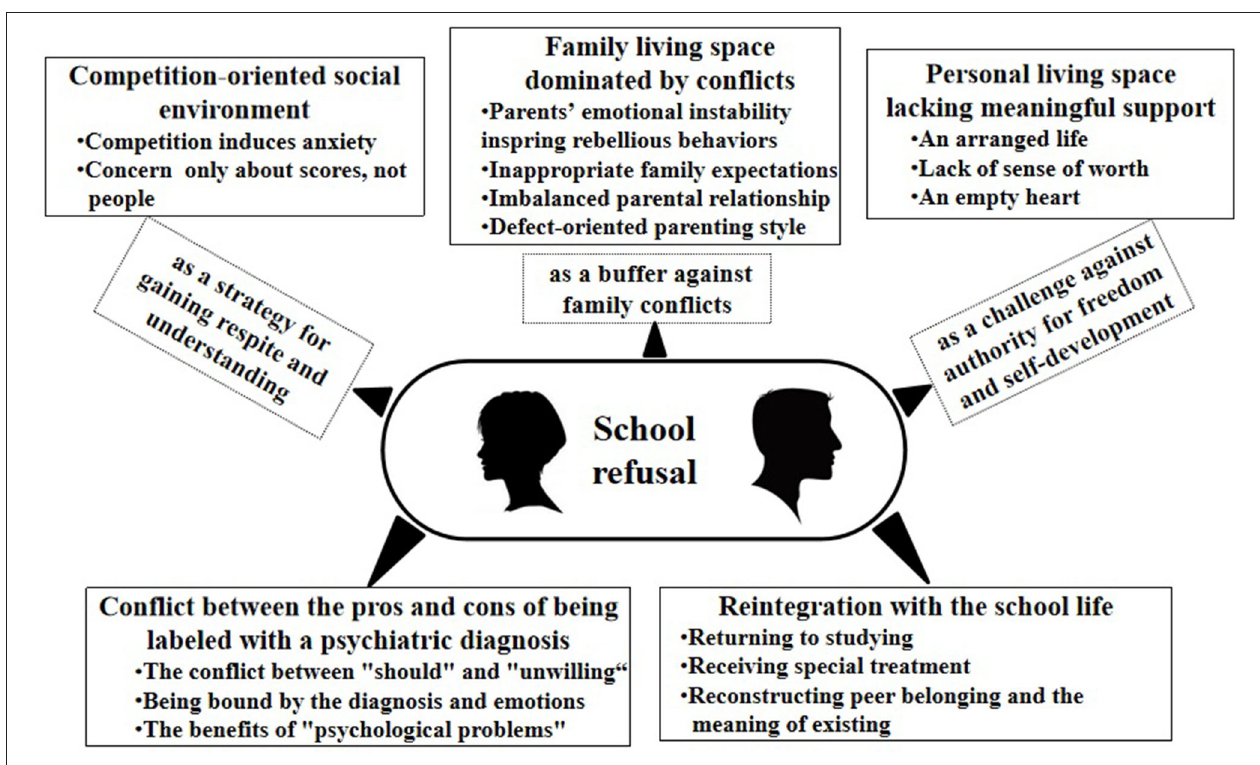
FIGURE 1 | The map of the